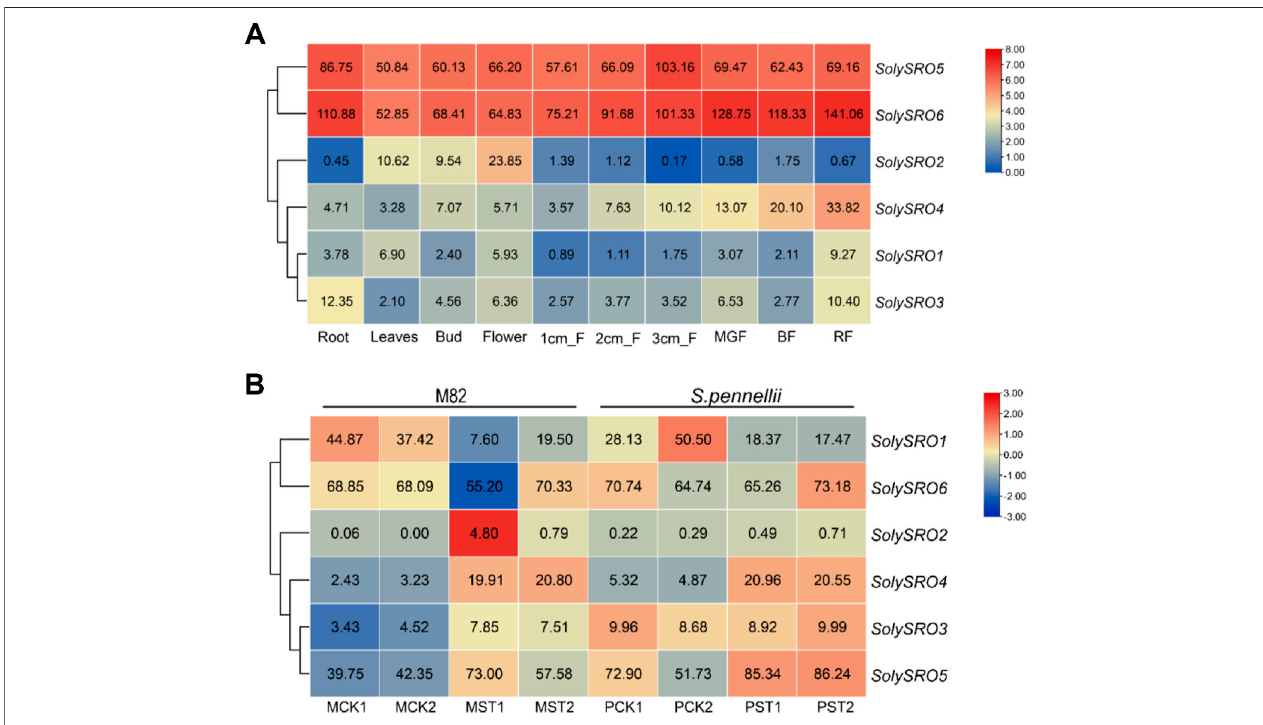
FIGURE 6 | Quantitative heat map of SRO gene expression. The color bar representsthe log 2 expression values, With red representing high expression levels and blue representing low expression levels. The gene name is shown on the right side. (A) Heat map of tissue-speci fi c expression of SRO genes in tomato. Heinz roots (Root),Heinzleaves(Leaves),Heinzunopened fl owerbuds(Bud),Heinzfullyopened fl owers(Flower),Heinz1 cmfruits(1 cm_F),Heinz2 cmfruits(2 cm_F),Heinz3 cm fruits (3 cm_F), Heinz mature green fruits (MGF), Heinz breaker fruits (BF), Heinz breaker + 10 fruits (RF) (B) Heat map of SRO gene expression in M82 and S. pennellii under salt stress. Normal growth of M82 (MCK), Normal growth of S. pennellii (PCK), Salt-stressed M82 (MST), Salt-stressed S. pennellii (PST), Each treatment has two